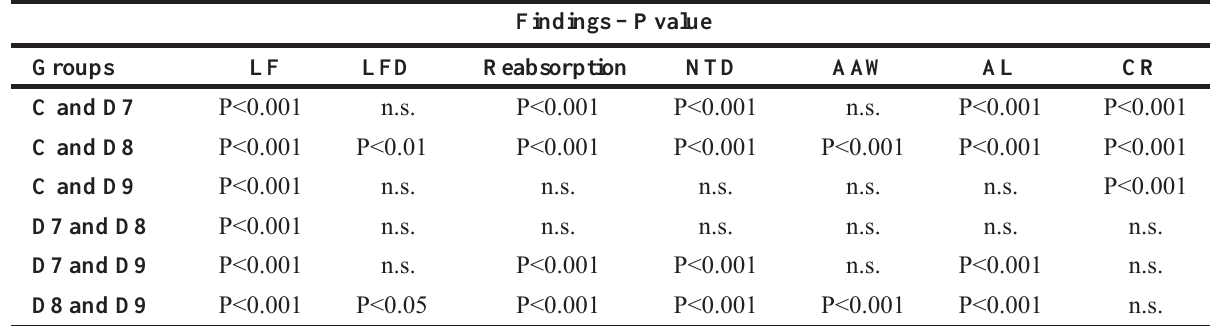
Table X. C = control, D = gestational day, LF = live fetuses, LFD = Late fetal death, NTD= Neural tube defect, AAW= Alteration of the abdominal wall, AL = alteration of the limbs, CR = caudal regression. n.s.= non-signi fi cant. TABLE 3 - Statistically signi fi cant difference between the control group and the different experimental groups regarding